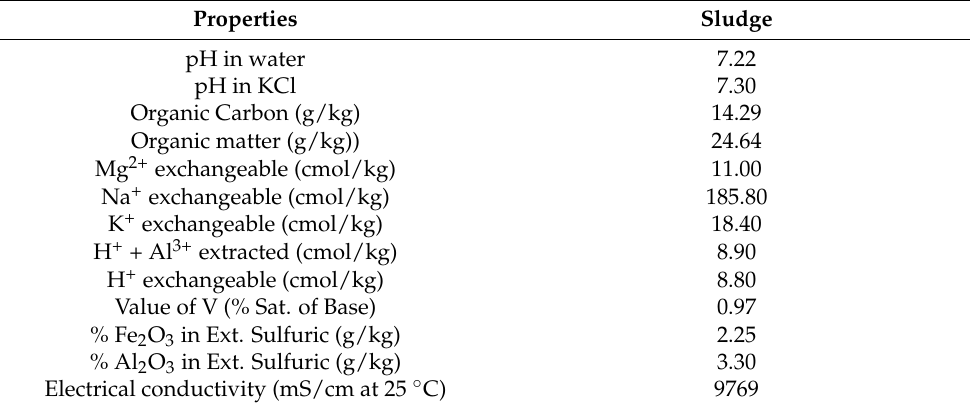
Table 1. Chemical characterization of the sewage